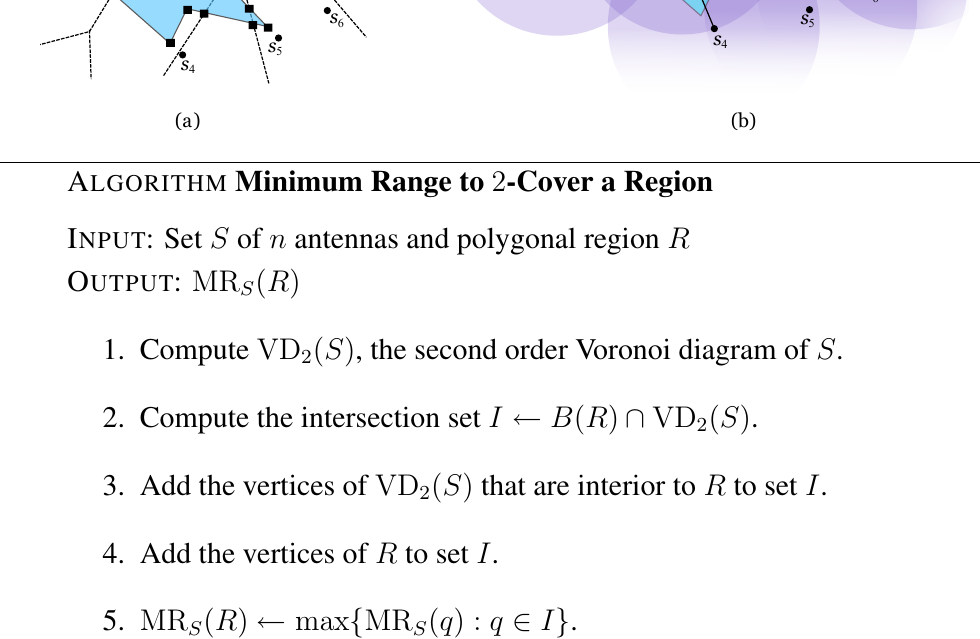
( S ) interior to R . (b) MR 2